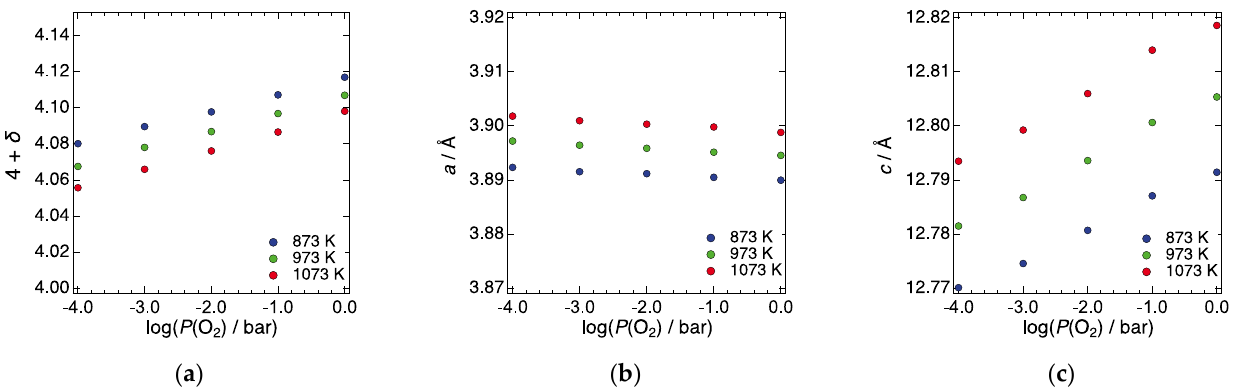
Figure 3. ( a ) Oxygen nonstoichiometry, ( b ) a -lattice constant, and ( c ) c -lattice constant of LN214 as a function of P (O 2 ) at 873, 973, and 1073 K in the P (O 2 ) range from 10 − 4 to 10 0 bar, which was taken from the literature [24,25].